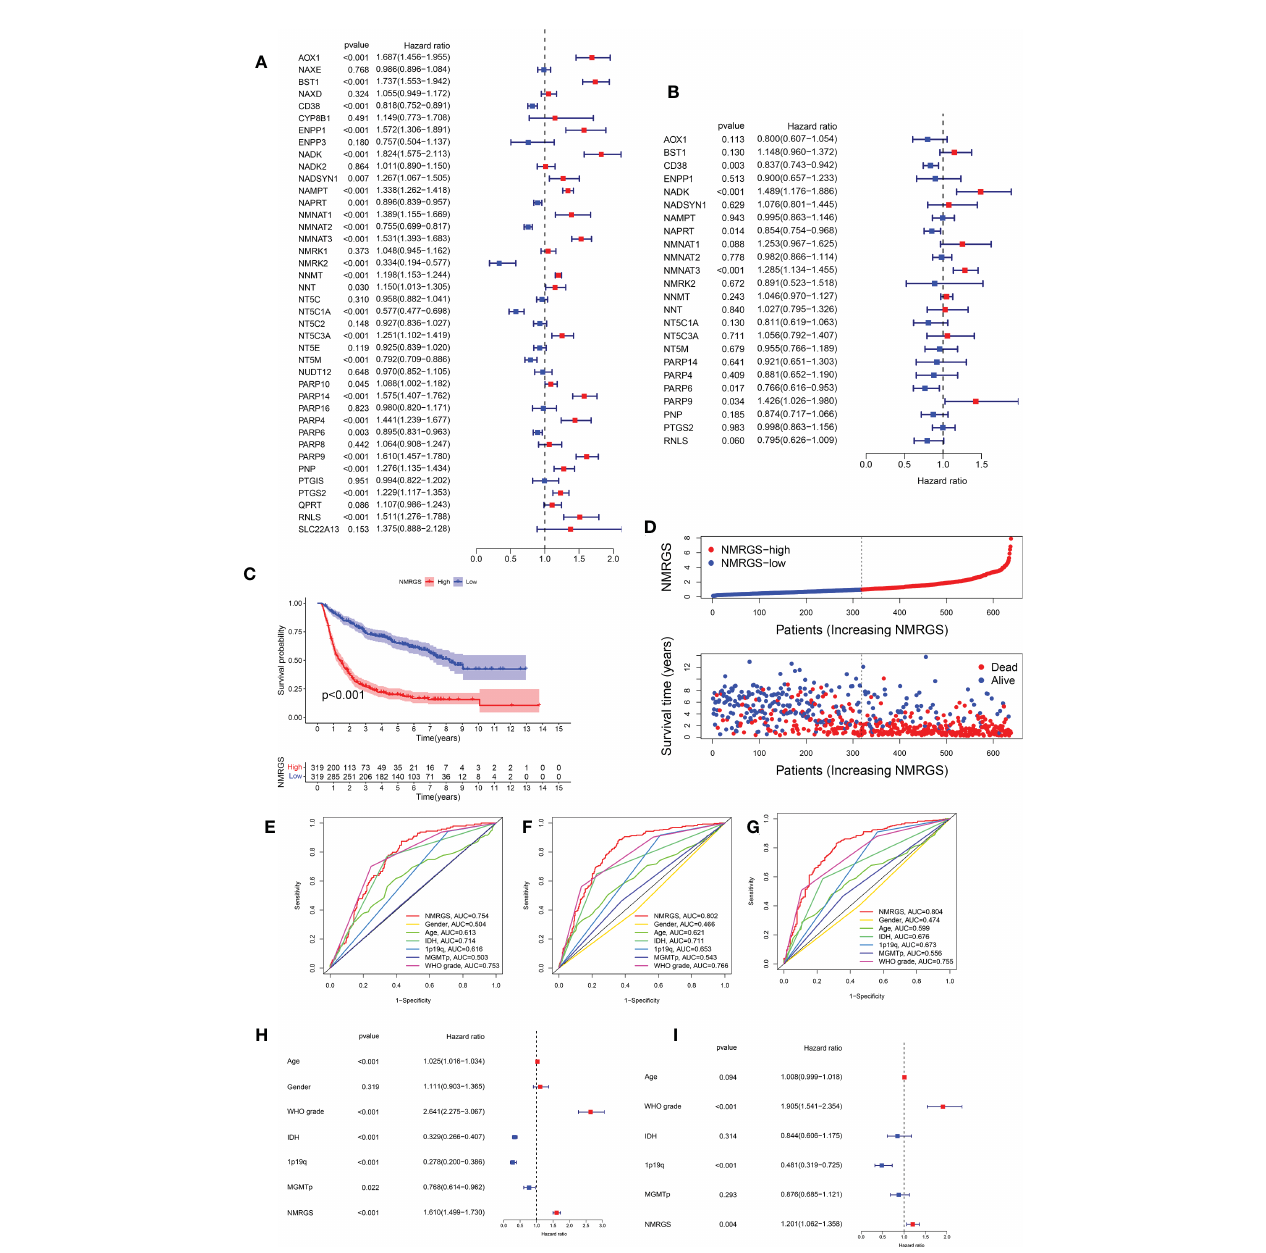
FIGURE 3 Development and validation of the NMRGS in CGGA693 cohort. (A) Univariate Cox regression analysis of the NMRGs. (B) Multivariate Cox regression analysis for NMRGS construction. (C) Kaplan-Meier analysis for survival in CGGA693 cohort. (D) Distribution plot of NMRGS score and survival status of glioma patients in CGGA693 cohort. (E-G) ROC curve analyses of NMRGS and the clinicopathological characteristics in predicting 1-, 3-, and 5-year overall survival in CGGA693 cohort. (H, I) Univariate and multivariate regression analyses of NMRGS and the clinicopathological characteristics in CGGA693